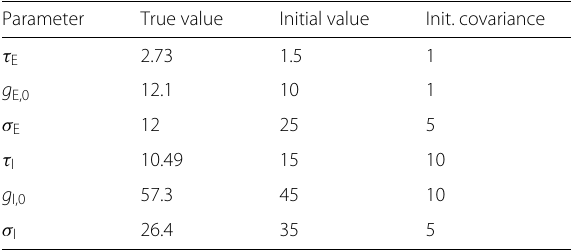
Table 3 True value, initial value, and covariance of the parameters in Fig.